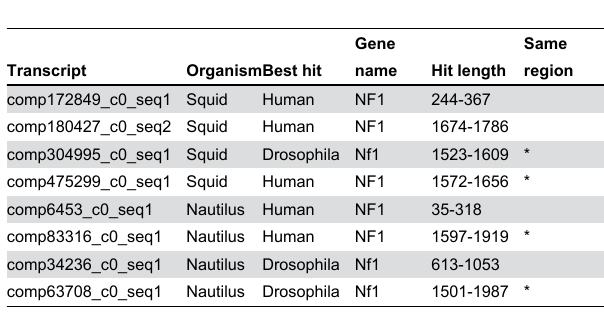
Table 2. Evidence of NF1 gene